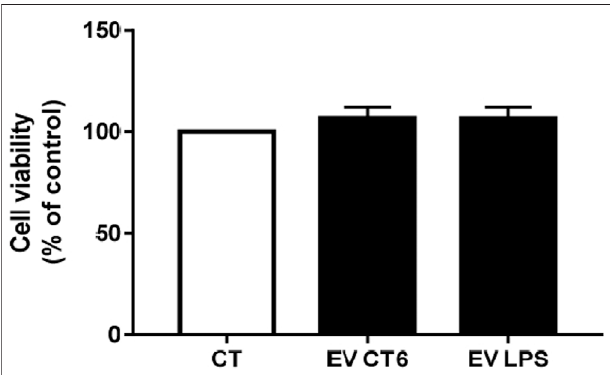
FIGURE 6 | Effect of macrophage-derived EVs on smooth muscle cell viability. MOVAS-1 cells were incubated for 24 h with EVs secreted by either treated (1 µg/ml LPS-EK; EV-LPS) or untreated macrophages (EV-CT) or without (CT). Cell viability was measured using the WST-1 assay. The viability of cells incubated without EVs (CT) was de fi ned as 100%. Data are expressed as the mean ± SEM of four independent experiments performed in triplicate ( n = 4). p < 0.05 is considered signi fi cant, Wilcoxon- Mann- Whitney test.